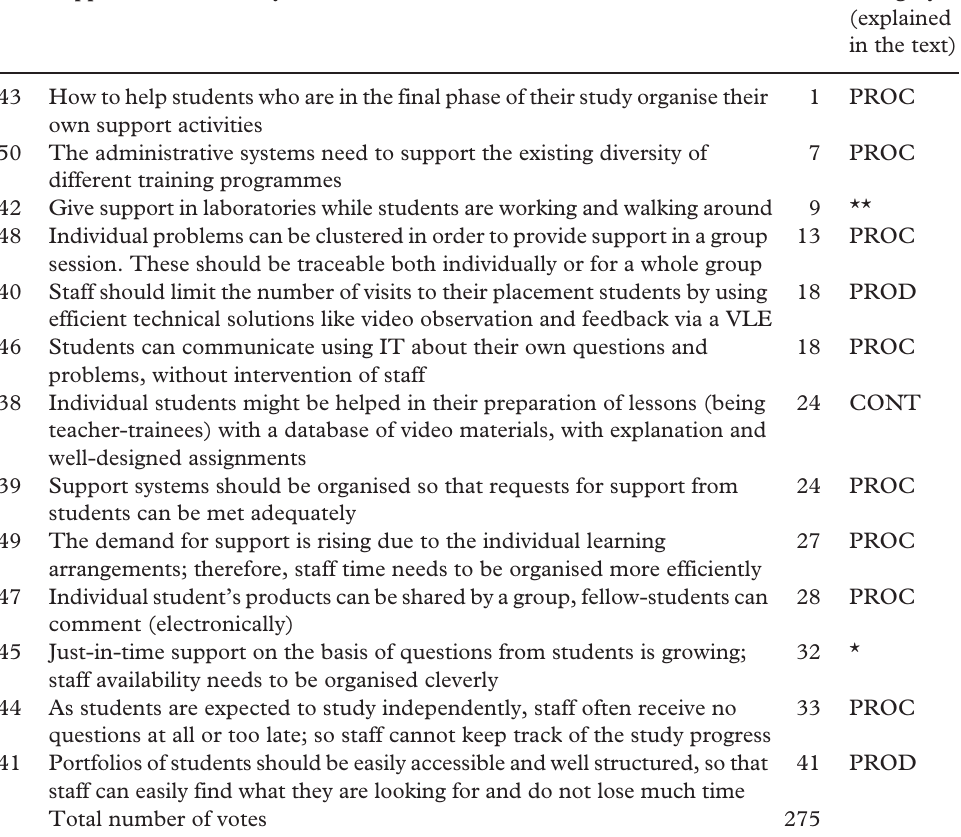
Table 2. Critical situations as identified by selected staff members of the Fontys Teacher Training School,